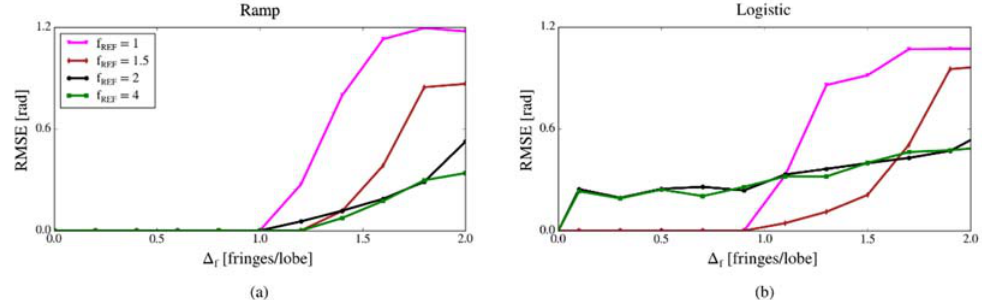
Figure 4. Sensitivity analysis with simulated data, algorithm robustness against along-lobe deformation differences between REF and IFG. RMSE of the demodulated unwrapped phase as a function of the difference in the along-lobe deformation rate ∆ f = f IFG − f REF for four different REFs along-lobe deformation rates f REF . The statistics are obtained by assuming ( a ) a ramp along-lobe deformation gradient or ( b ) a logistic gradient (curve steepness κ =